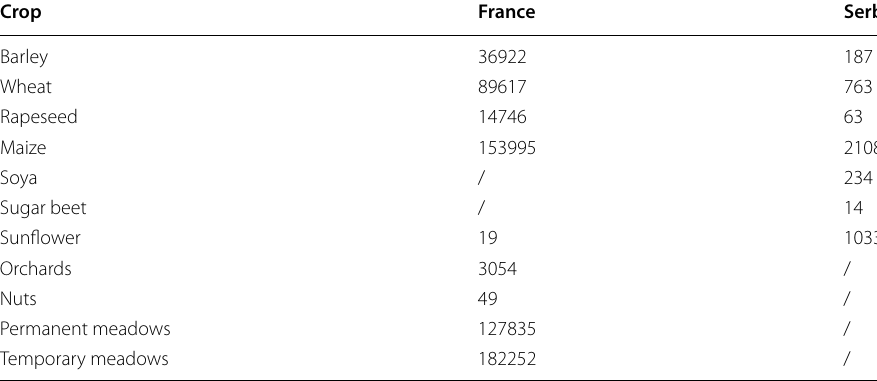
Table 2 Crop types and number of labels in two datasets Crop